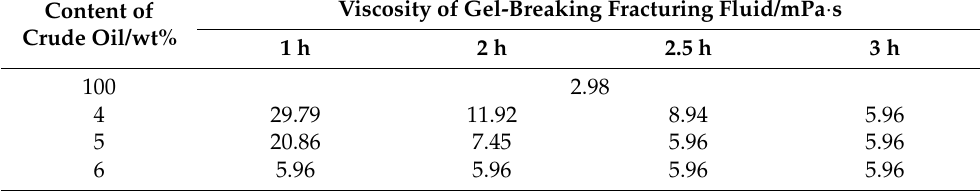
Table 1. Gel-breaking property of the VES-based fracturing fluid (2% EAPB + 0.5% OAPB + 0.1% KCl) at 60 ◦ C.